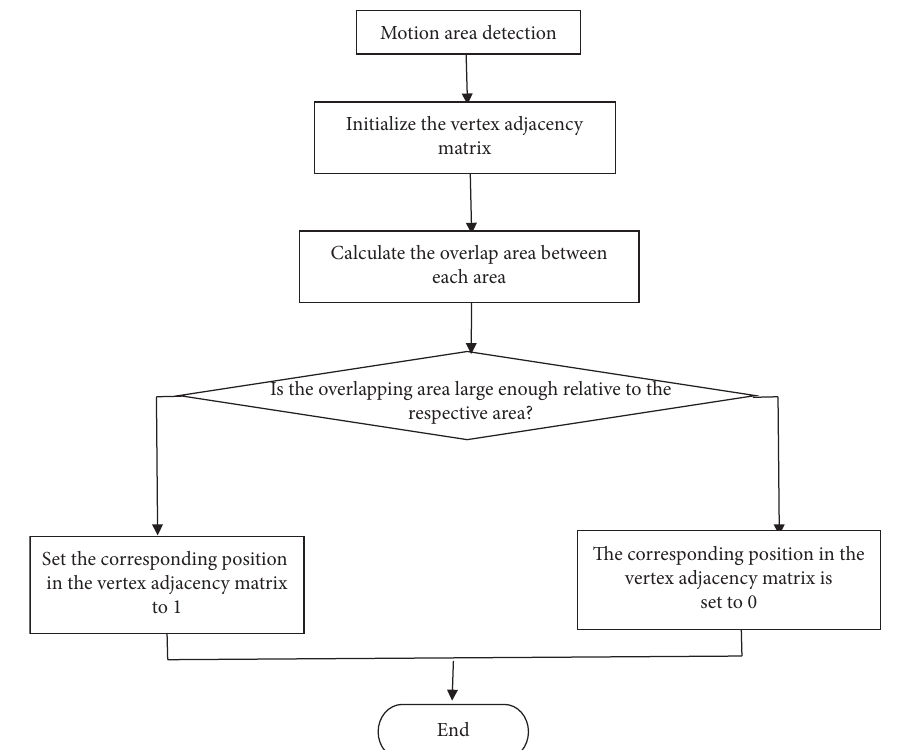
Figure 2: Flowchart of the construction of the vertex adjacency matrix.